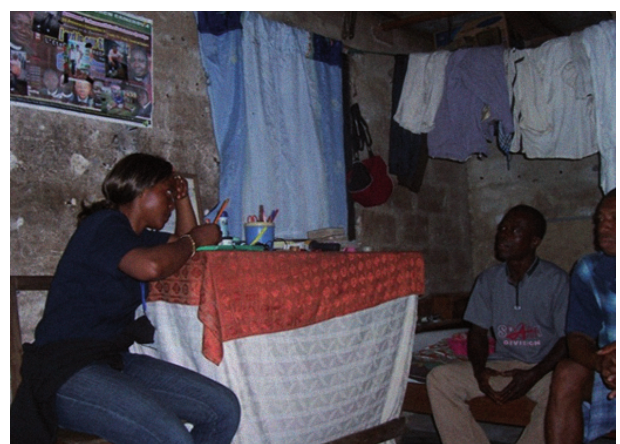
Figure 5. Project assistant Miss Sylvia Ngubienka’a (Buea University) conducting an interview in Pidgin in the Mapanja community (Buea) in the framework of the FP7 MIA-VITA 2nd fieldwork campaign, Fako division (Cameroon).